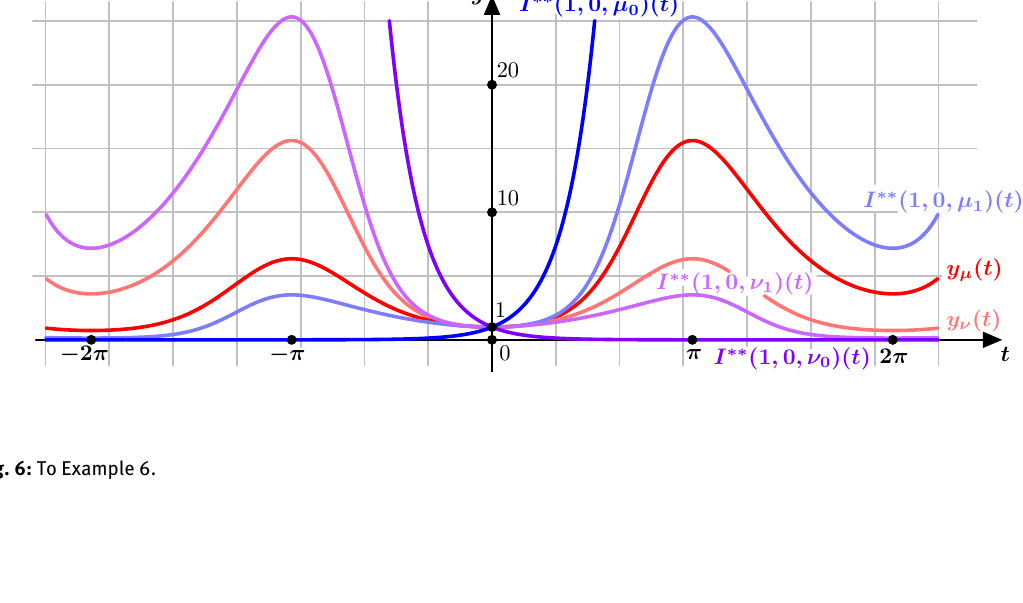
Fig. 6: To Example